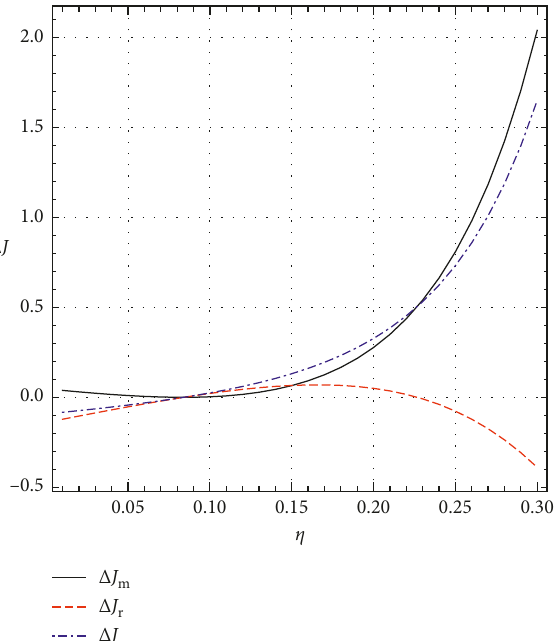
Figure 6: Comparison of steady-state profits with k .